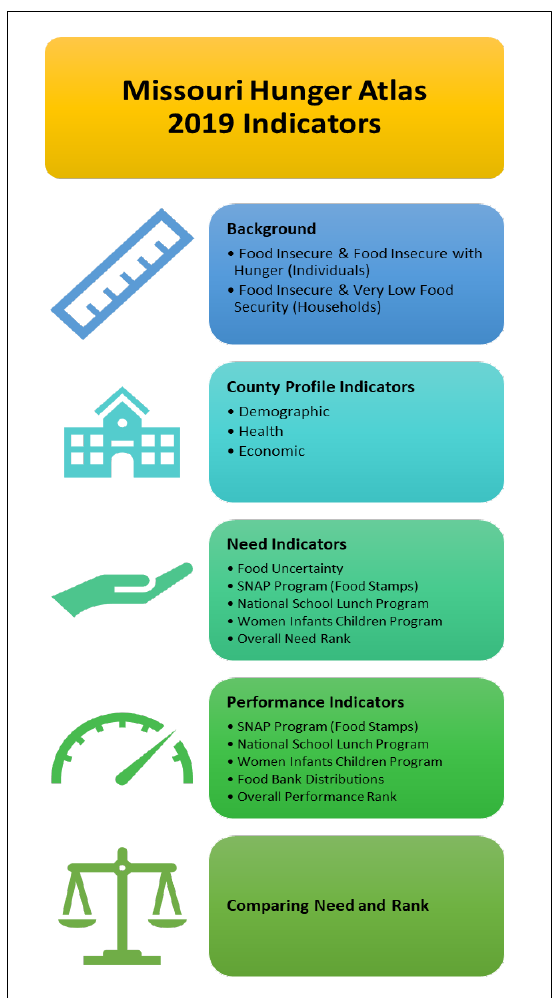
Figure 1. Missouri Hunger Atlas